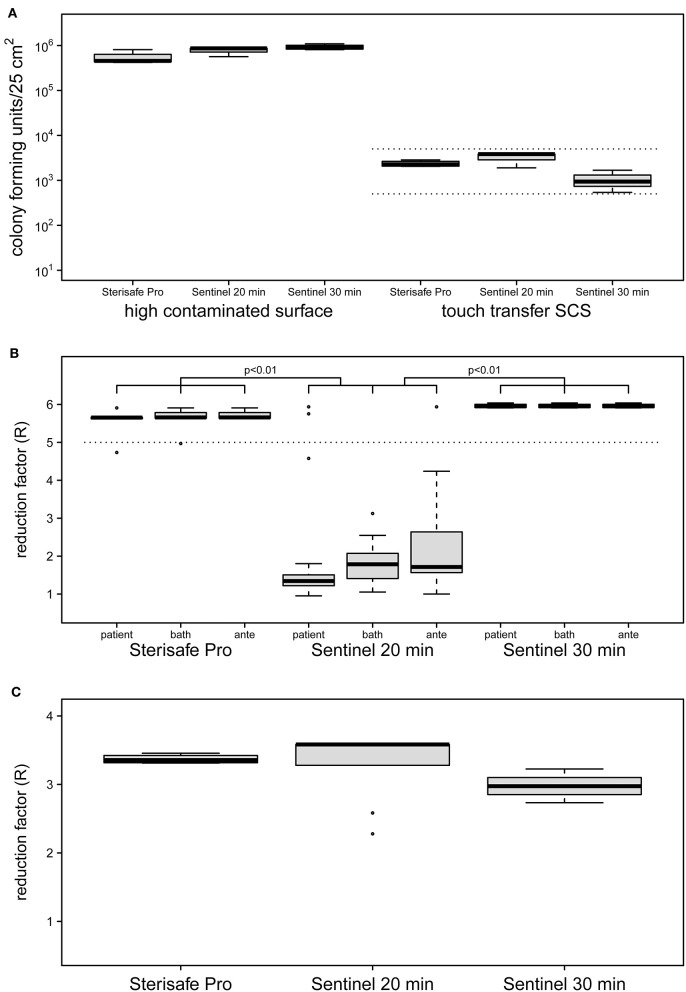
Initial contamination of HCS and SCS surfaces (A) and reduction factors achieved by two different automated room decontamination devices (B,C). The distribution of contamination used for the experiments (A) are shown separately as boxplot for the HCS and the SCS for the equipment and processes performed. Only SCS that met an initial surface load of 5 × 102-5 × 103 cfu were included (dashed lines). The effectiveness of the disinfection processes was determined in several independent experiments with quantification of recoverable bacterial load in duplicate (STERISAFETM Pro [n = 4], Sentinel 20 min [n = 3], Sentinel 30 min [n = 4]). The distribution of the calculated reduction factors for the HCS (B) and the SCS (C) is shown separately as a boxplot for the patient room, the bathroom and the anteroom. Disinfection using STERISAFETM Pro as well as a 30-min nebulization of H2O2, achieved the mean reduction rate of 5 log10 (B, dashed line) required for a process recognized as disinfection. Both disinfection processes were superior to a 20-min nebulization of H2O2, as confirmed with the HCS (p < 0.01 paired t-test with Bonferroni correction). Realistic bacterial contamination was completely eliminated (C) for both processes (for aHP regardless of nebulization time). The differences in the distribution of the reduction rates displayed in the boxplots, results exclusively from the differences in the contamination used (A, right side).